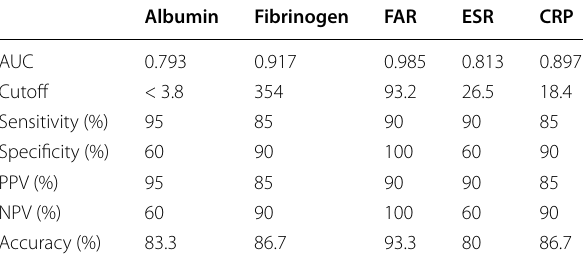
Table 6 Validity of albumin, fibrinogen, FAR, ESR, and CRP for the prediction of activity